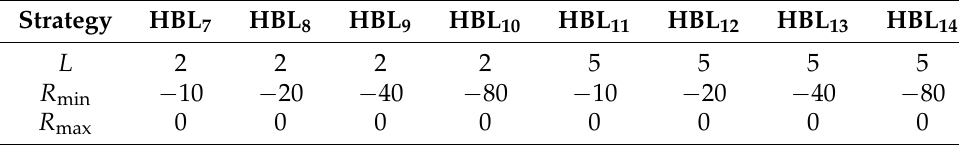
Figure 18. Total background-trader surpluses and HBL strategy adoption rates achieved at equilibria across different market settings. For each market environment, we compare four settings where background traders are, respectively, provided with the standard HBL strategy (dark grey), HBL with selective price blocking (light grey), HBL with price offsets (white) and HBL that combines the two variations (striped). Each marker specifies one equilibrium outcome in markets with spoofing (orange) and without spoofing (blue). Table 7. A set of second HBL variations with different price